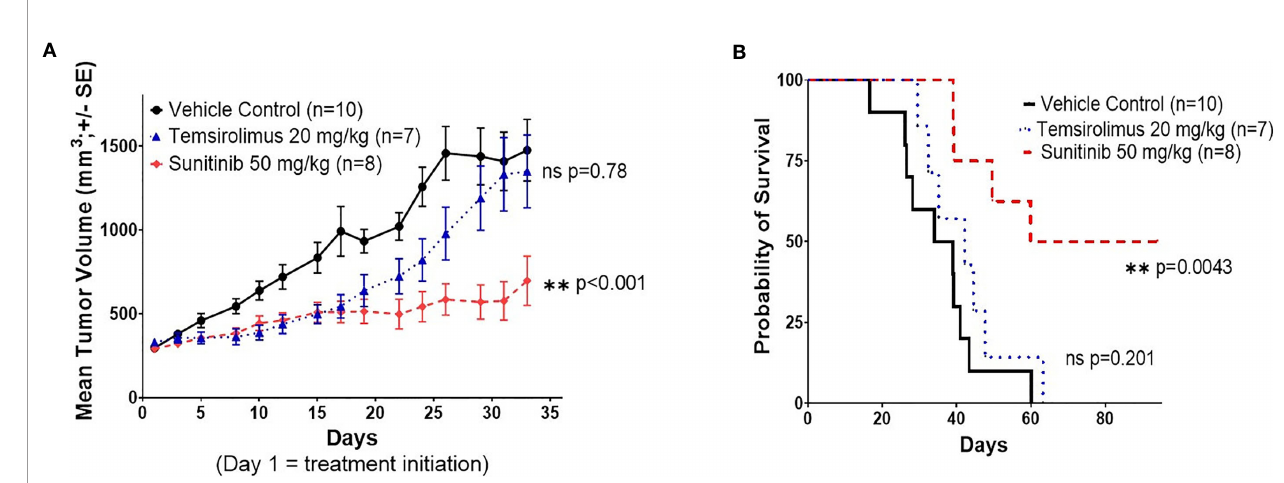
FIGURE 4 | Sunitinib shows signi fi cant therapeutic ef fi cacy in the RMC PE PDX. (A) Tumor volume response curve for P1 NSG mice engrafted with P0 malignant PE tumor cells treated with vehicle control, sunitinib, or temsirolimus. Treatment was initiated on day 1. Each data point represents the mean tumor size of all mice in one treatment group at a given time point, measured three times a week. Error bars represent 1 standard error from the mean. P values represent comparisons of overall growth rate calculated by fi tting mixed effects models to log(volume). (B) Kaplan-Meier survival curve for the same study in (A) . Survival was measured until day 94 after